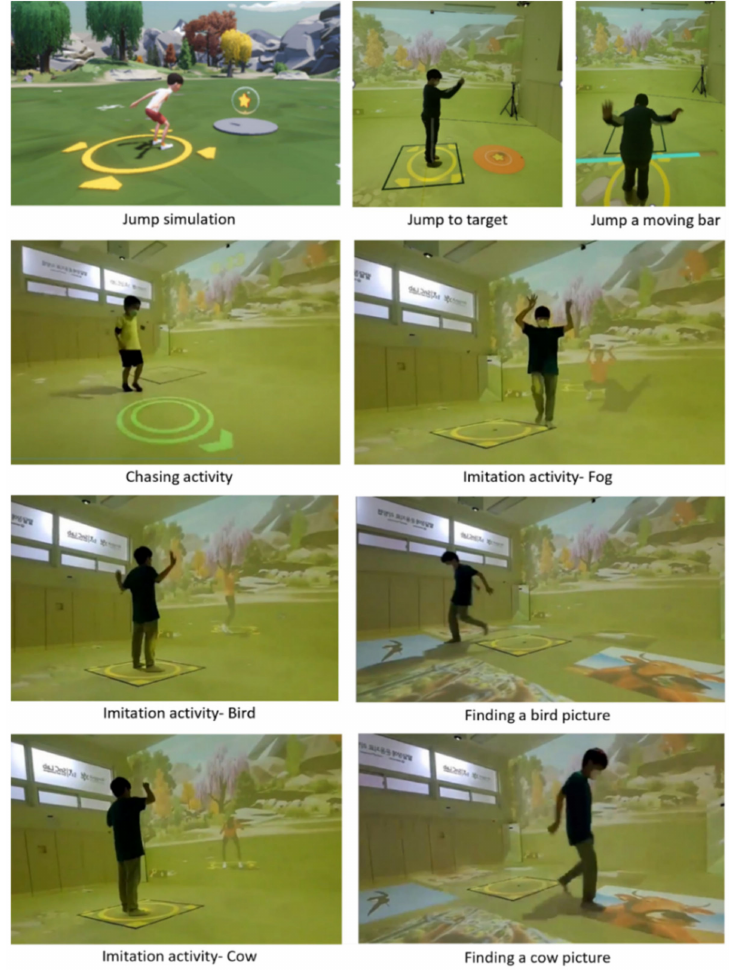
Figure 1. Locomotor skill simulation and actual execution in information and communications technology (ICT)-based